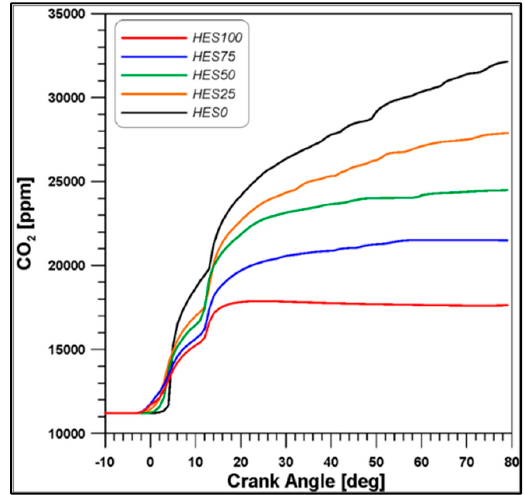
Figure 30. CO 2 emissions.